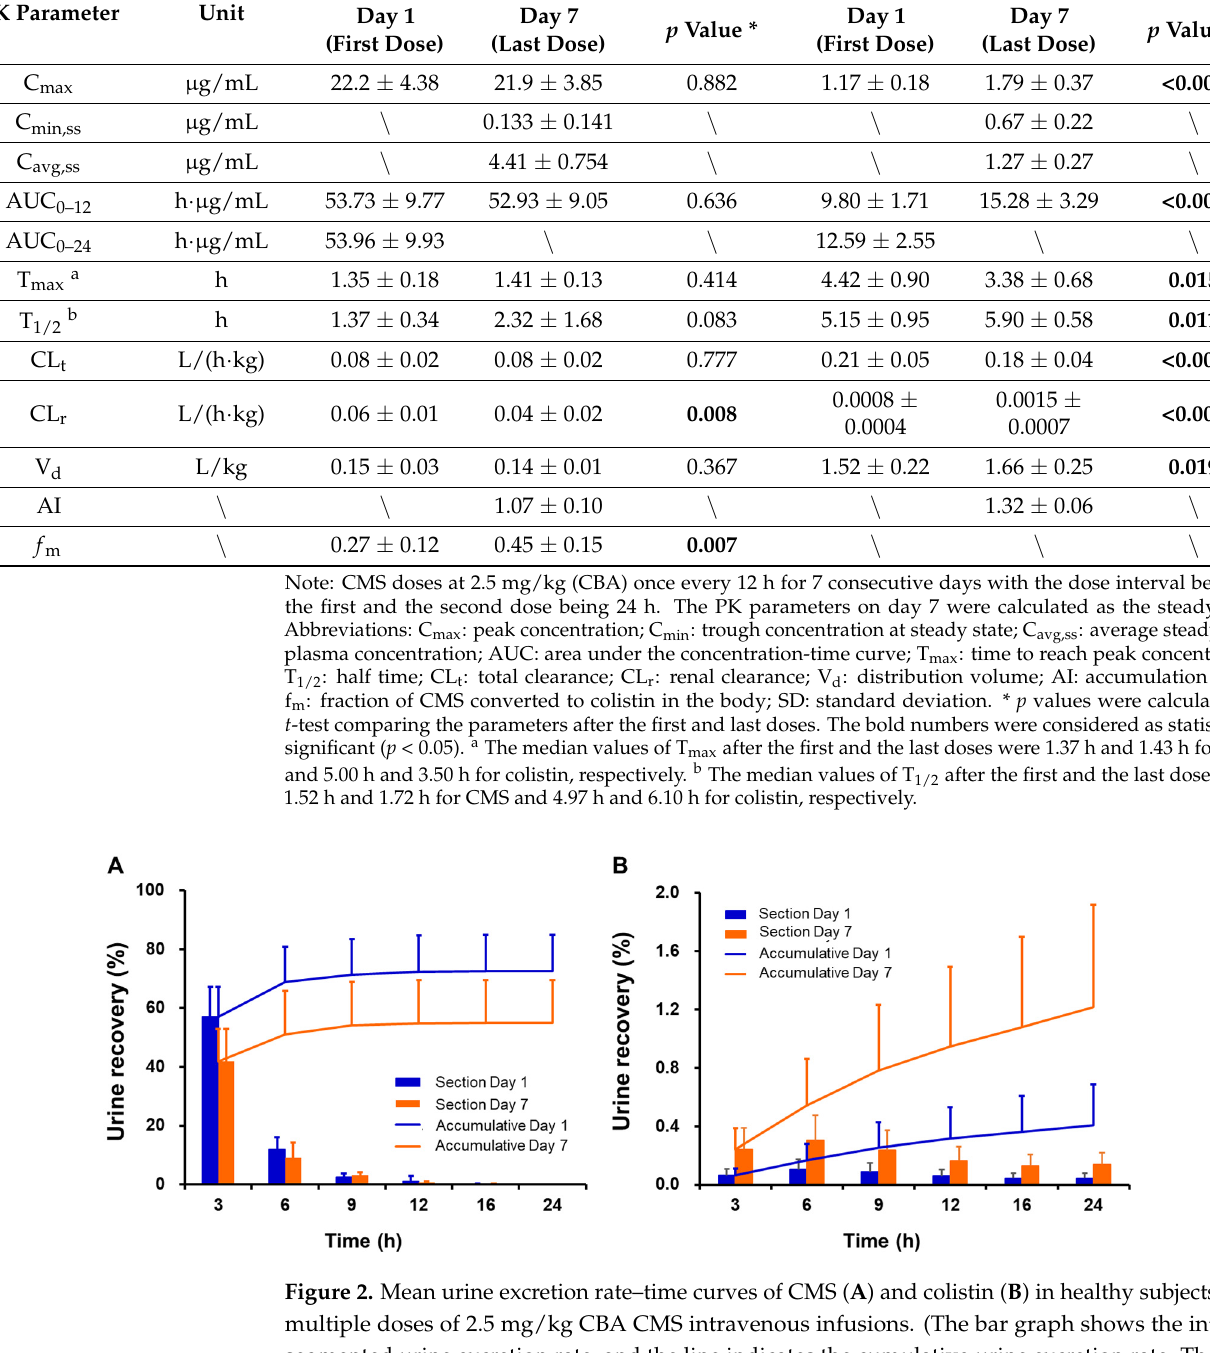
Table 1. Summary of pharmacokinetic parameters in healthy Chinese subjects after multi-dose in- travenous infusions of CMS (mean ± SD, n = 12).